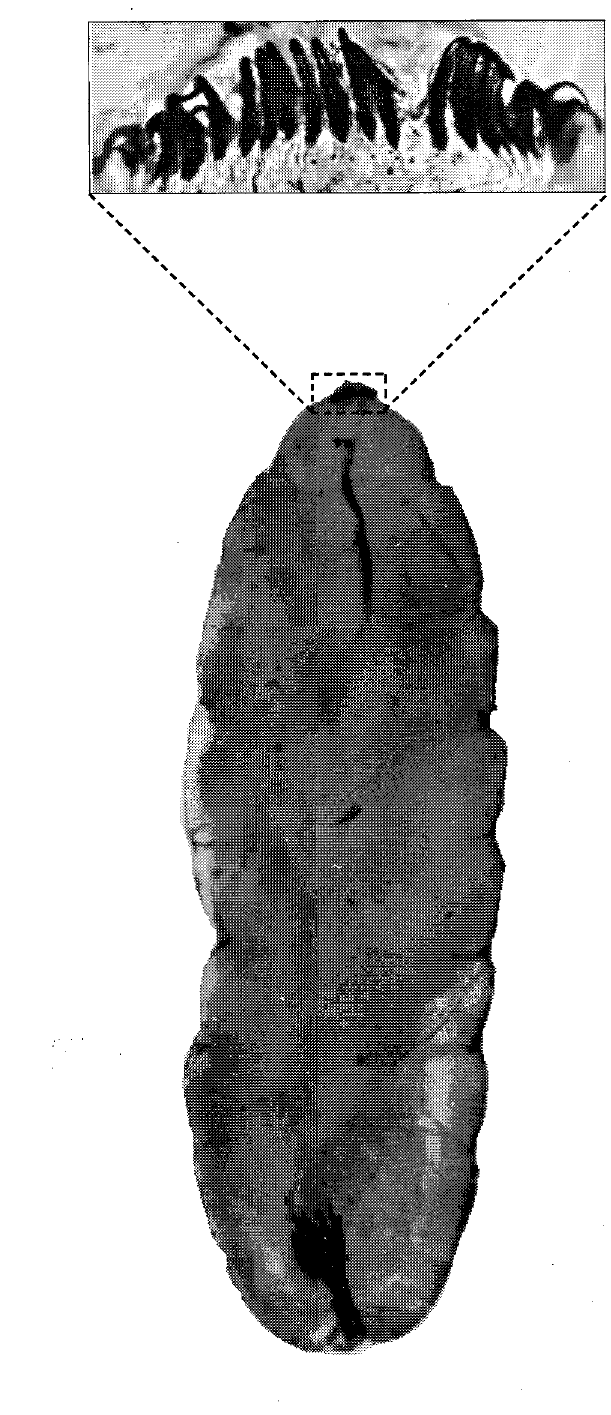
Fig. 2. C. ulrichii larvae (first instar) found in moose in Pasvik in northeastern Norway. There are 18 hooks on the anal pecten which distinguishes it from the reindeer nose bot fly C. trompe. Photo: Mike